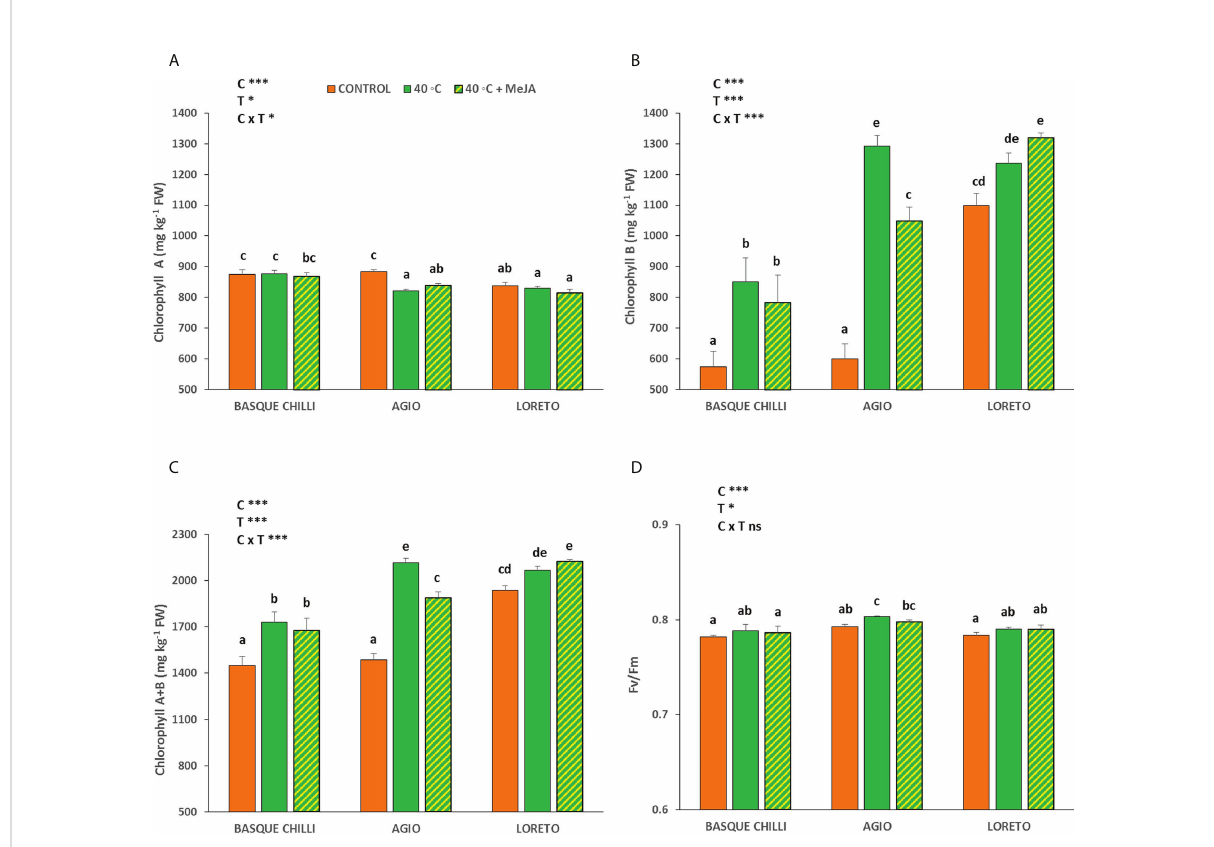
FIGURE 2 Effects of heat shock and MeJA on (A) Chlorophyll a, (B) Chlorophyll b, (C) total Chlorophylls (a+b), and (D) the maximum potential quantum ef fi ciency of photosystem II (Fv/Fm) in leaves of the three pepper cultivars. Values are means ± SE. Different letters indicate signi fi cant differences between treatments according to Duncan ’ s test at the 95% con fi dence level. The * refers to signi fi cant differences at the level of p ≤ 0.05; ***p ≤ 0.001; n.s., not signi fi cant. C is cultivar; T is